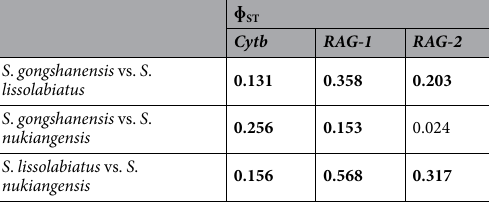
Table 2. Pairwise ɸ ST values among the three species based on Cytb and two nDNA genes. The values in bold are significant at P < 0.05.